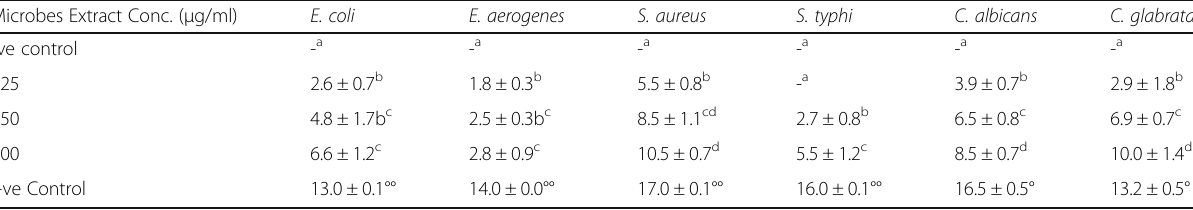
Table 2 Antimicrobial activity of T. clypeatus against some bacteria and yeast species Microbes Extract Conc. ( μ g/ml)